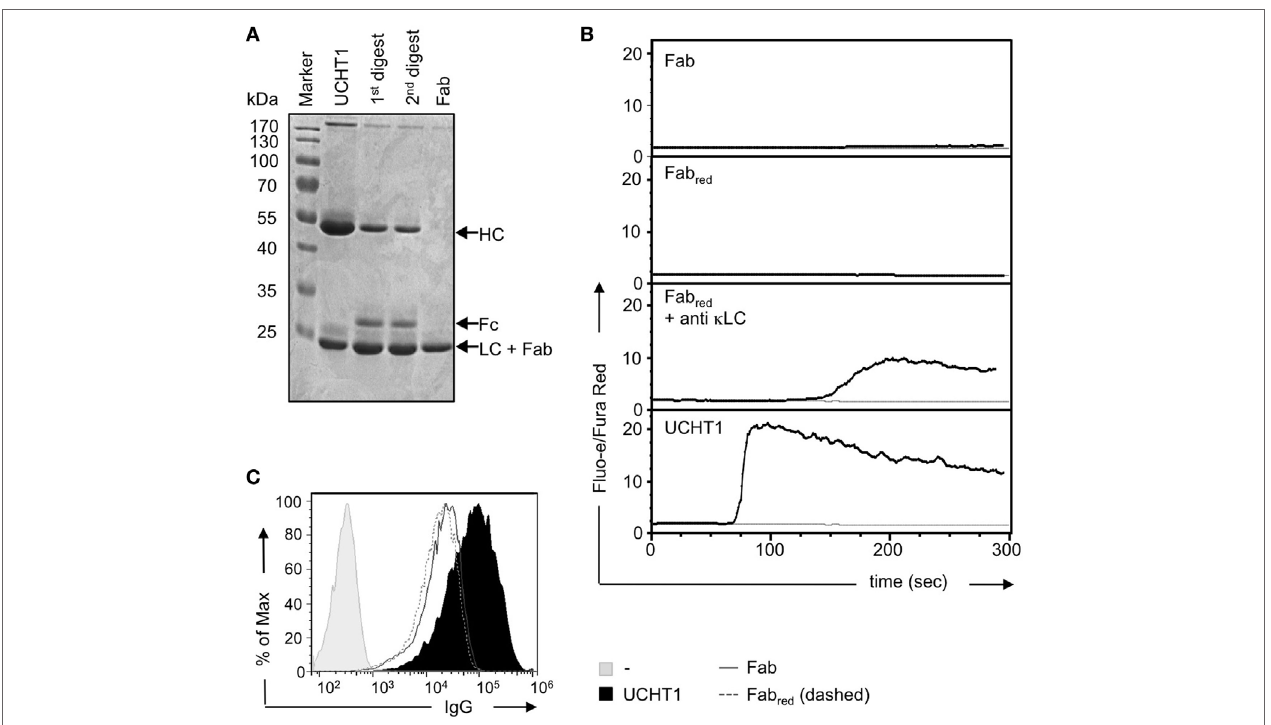
FigUre 3 | Preparation of UCHT1 Fab fragments. (a) The anti-CD3 ε antibody UCHT1 was digested with papain using a kit from Thermo Fisher Scientific. The Fab fragments were purified with protein A coupled beads. The complete antibody (lane 1), the first and second digestions (lanes 2 and 3), and the purified Fab fragment (lane 4) were separated by reducing SDS-PAGE followed by Coomassie staining ( n > 3). (B) Jurkat V γ 9V δ 2 cells were labeled with Fluo-3 AA and Fura Red AM and the baseline of cellular Ca 2 + was measured by flow cytometry for 1 min. The indicated reagents were then added and Ca 2 + levels were measured for additional 6 min (black lines). The gray lines represent baseline Ca 2 + level without addition of any stimuli ( n > 3). (c) Concanavalin A expanded γδ T cells were stained with UCHT1, Fab, Fab red , or left untreated, followed by an APC-labeled anti-mouse IgG antibody as a secondary reagent. Fluorescence intensities were quantified by flow cytometry ( n >